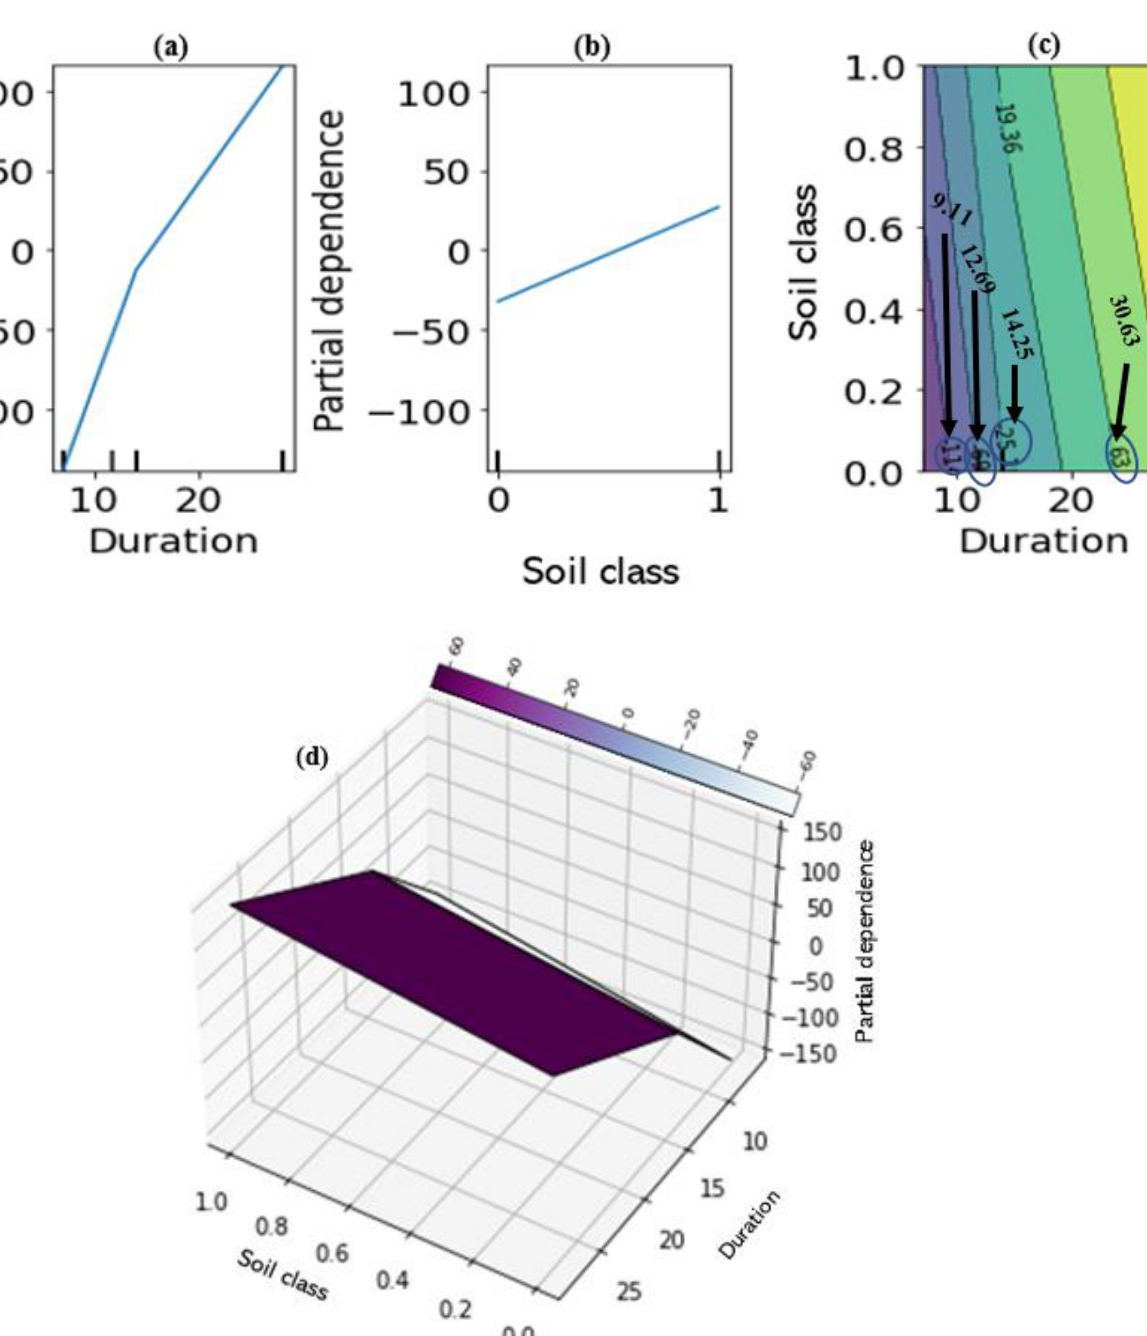
Figure 15. Partial dependence plots: ( a ) one-way dependence for duration of curing, ( b ) one-way dependence for soil class, ( c ) two-way dependence for curing duration and soil class, ( d ) 3-dimensional two-way dependence for curing duration and soil class (Python, version 3.8).